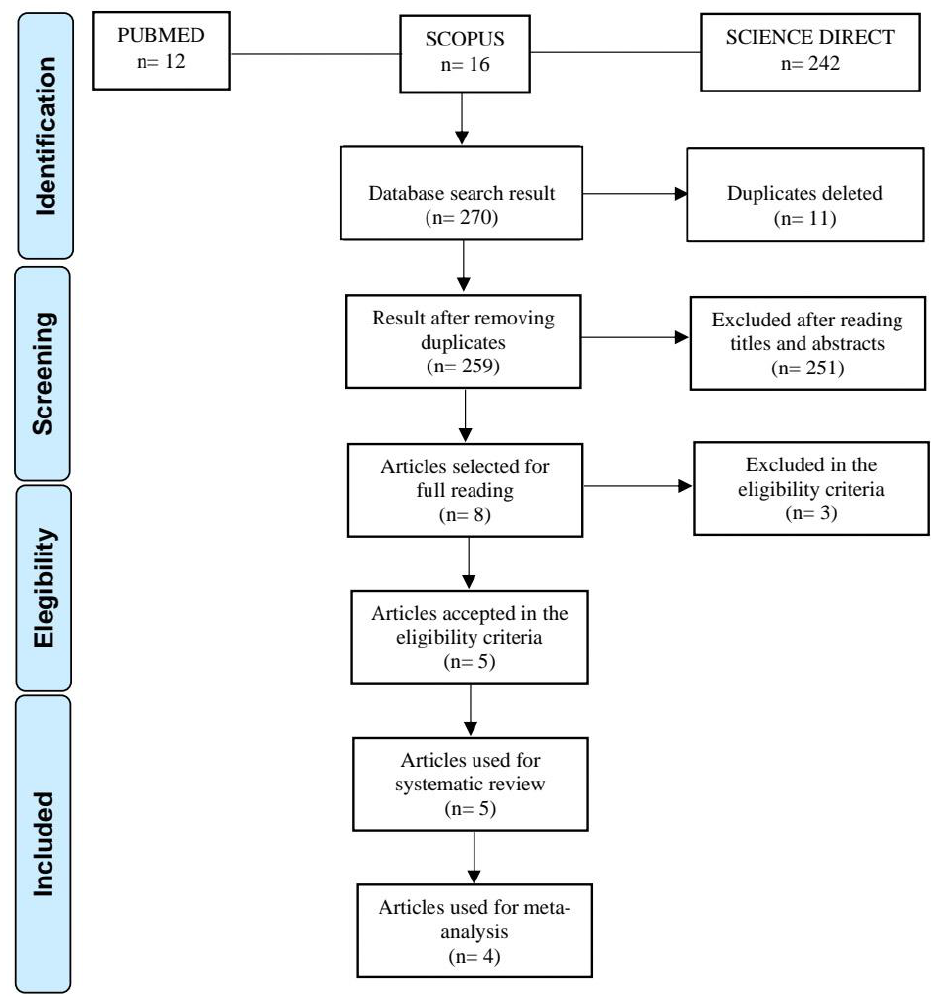
Figure 1. PRISMA flowchart demonstrating steps of the systematic review and meta-analysis.